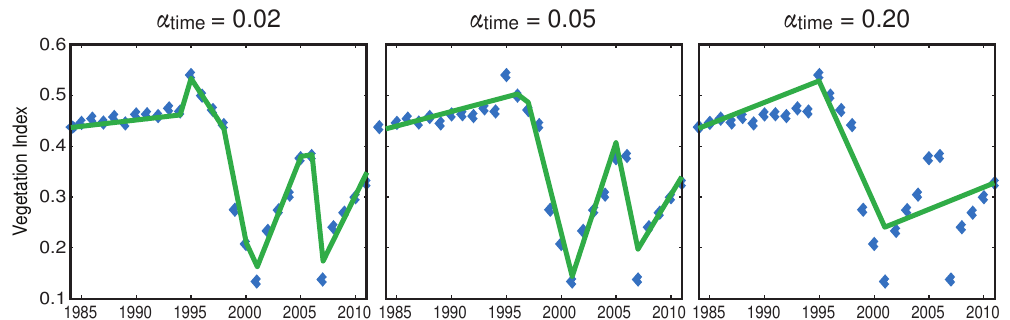
Figure 4. Total variation regularization over the time series generates many quick events or fewer, longer-term events depending on the strength of α time